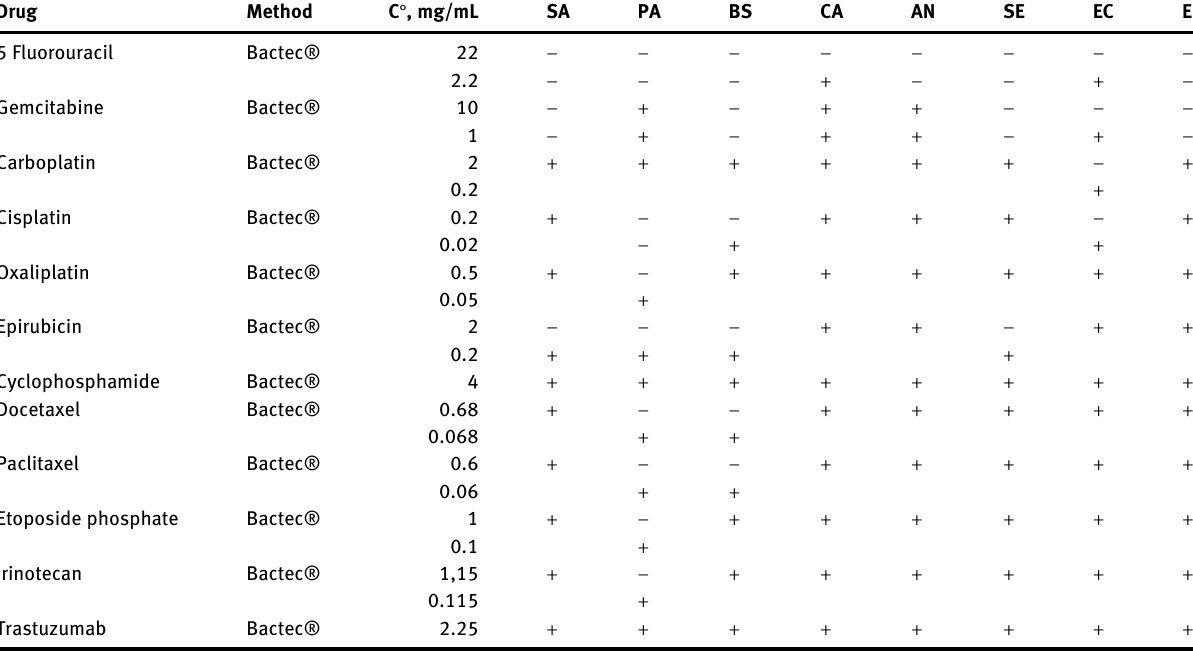
Figure 3: Microscopic observations (magnification × 20) of correct seals and defect seals using toluidine blue dye penetration test with S422VM heat sealer.